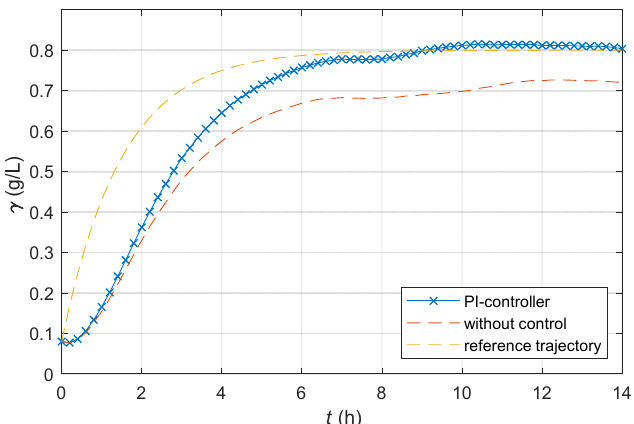
Figure 10. Time course of the dissolved CO 2 concentration γ of the laboratory batch bioreactor with a PI control system; additionally, the time course of the CO 2 concentrations of a non-controlled laboratory bioreactor and the time course of the reference CO 2 concentration are presented for comparison.